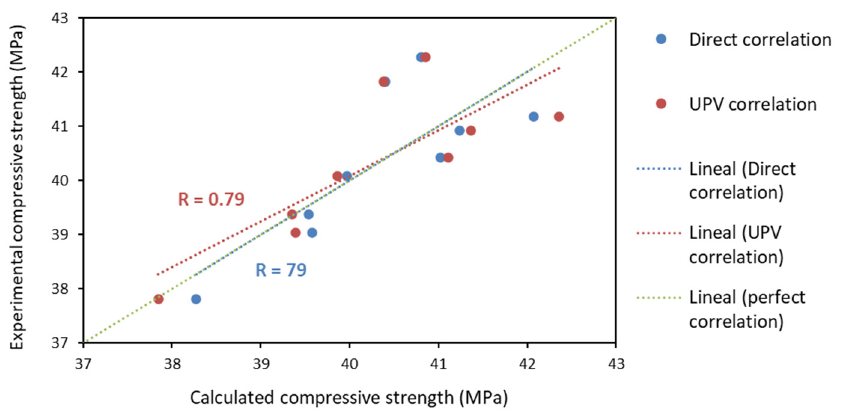
Figure 19. Relation between calculated and experimental compressive